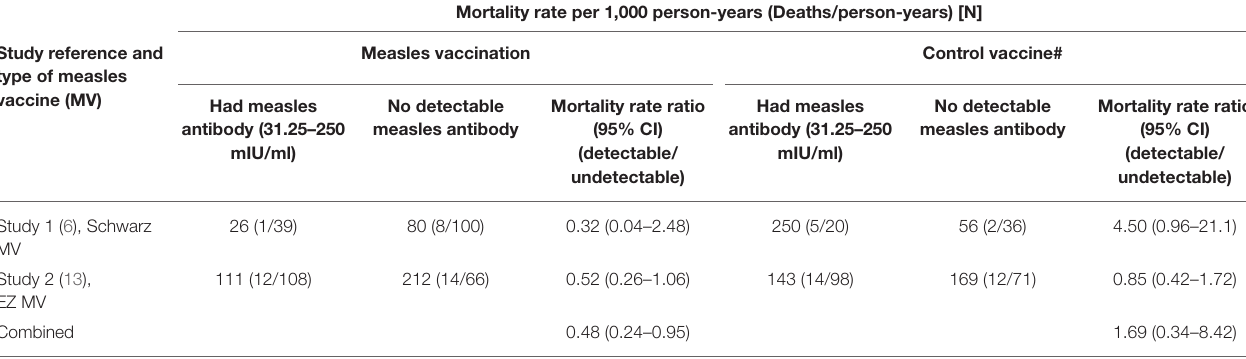
TABLE 2 | Mortality according to level of measles antibody at time of vaccination with measles vaccine or control vaccine. Mortality rate per 1,000 person-years (Deaths/person-years)